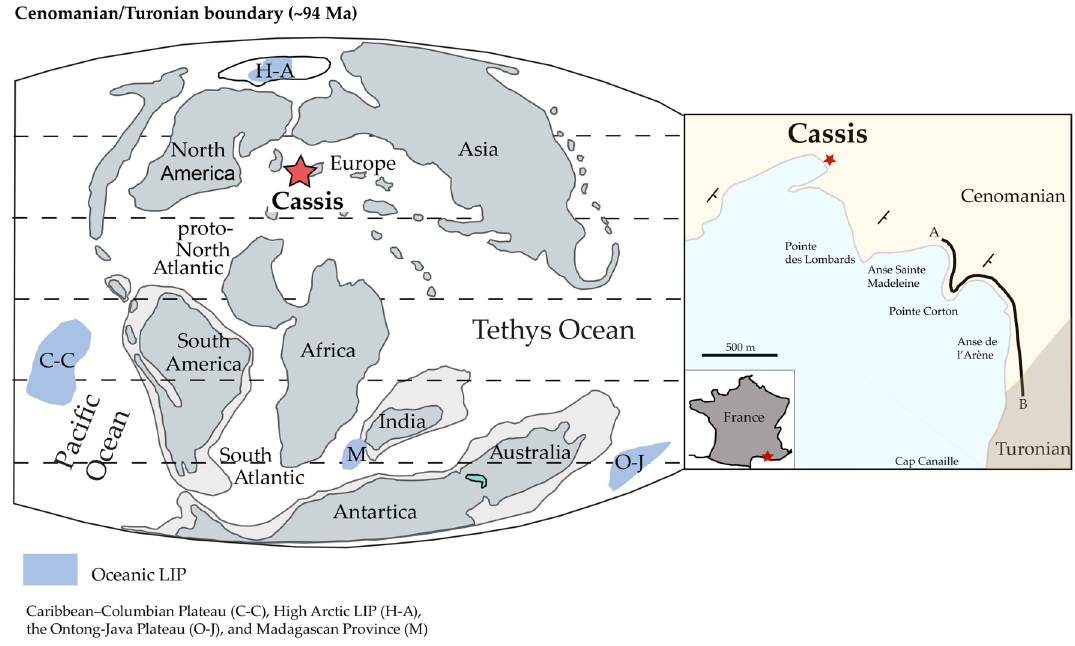
Figure 1. Simplified Late Cretaceous paleogeographical map, location map and the studied stratigraphic section ( A , B ). Figures modified after 57,60 ,